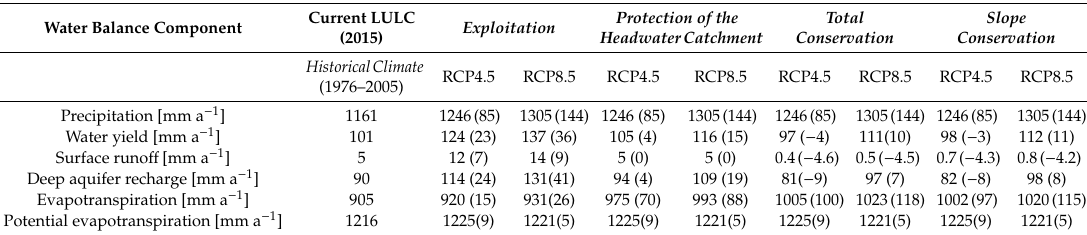
Table 5. Impact of combined LULC and climate change on selected water balance components. Brackets () show the relative change in the water balance components compared to the reference period with historical climate. The RCP scenario data shows the ensemble mean of all model